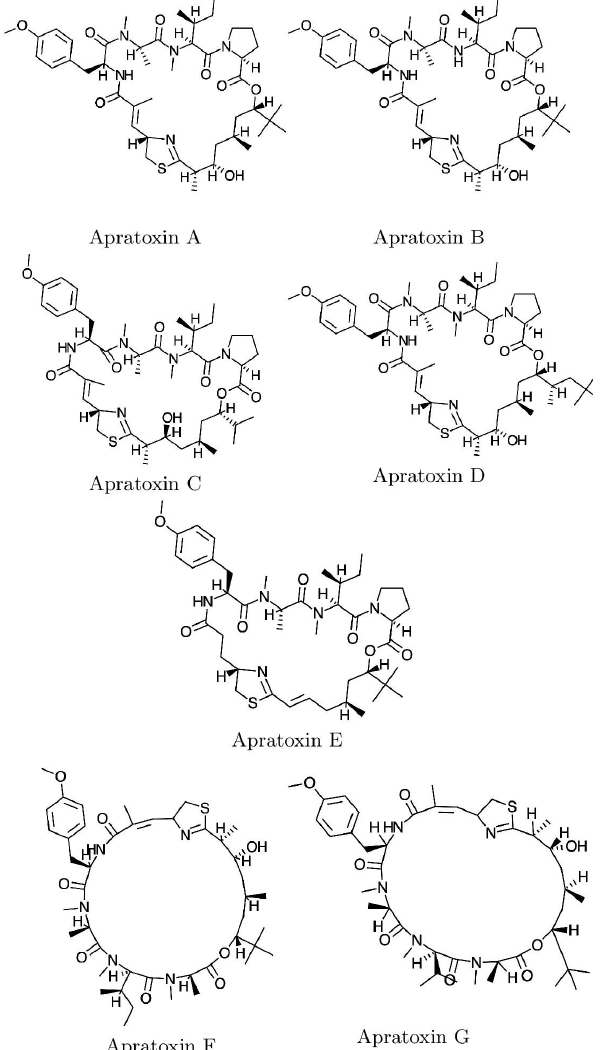
Figure 1. Graphical sketches of the molecular structure of Apratoxin A, Apratoxin B, Apratoxin C, Apratoxin D, Apratoxin E, Apratoxin F and Apratoxin